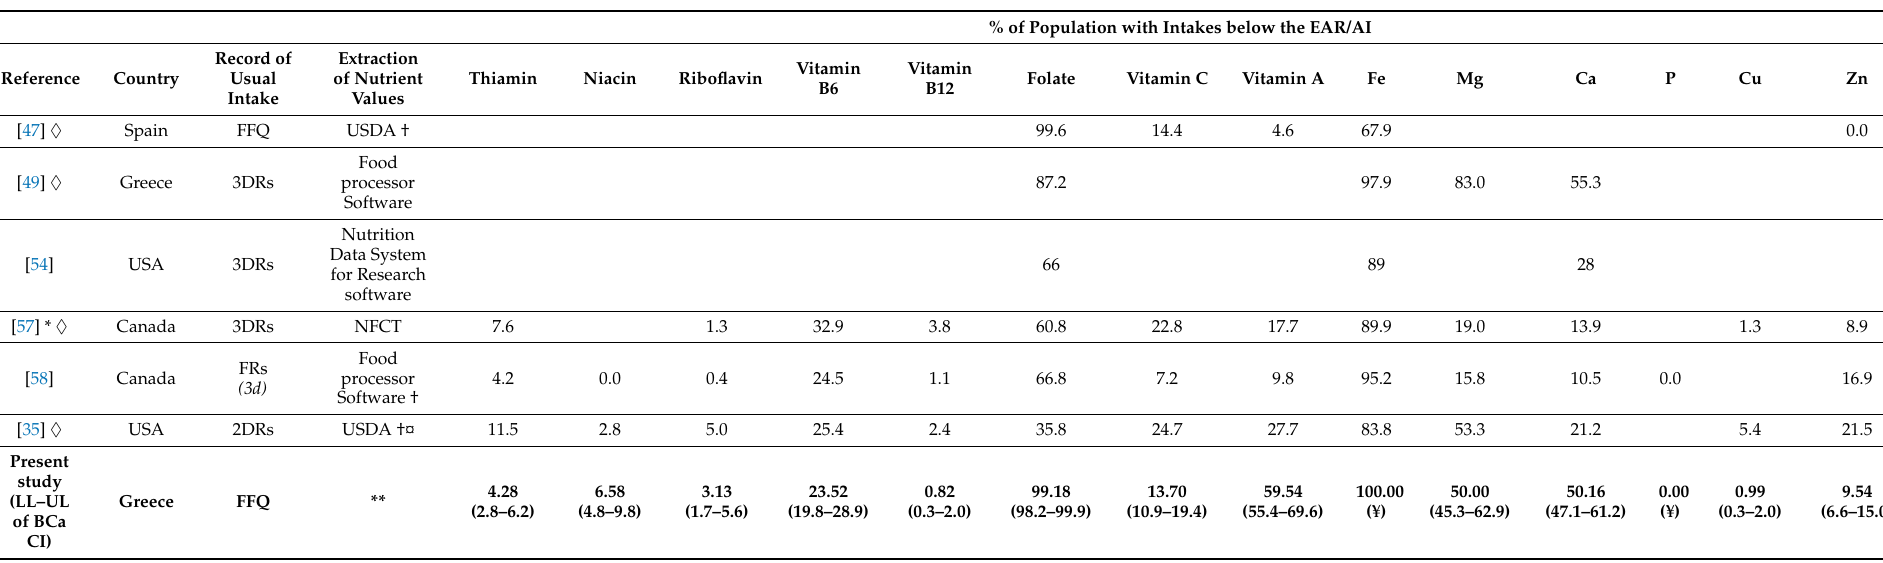
Table 7. Data regarding the percentage of pregnant population with intakes below the EAR/AI as reported by selected studies. % of Population with Intakes below the